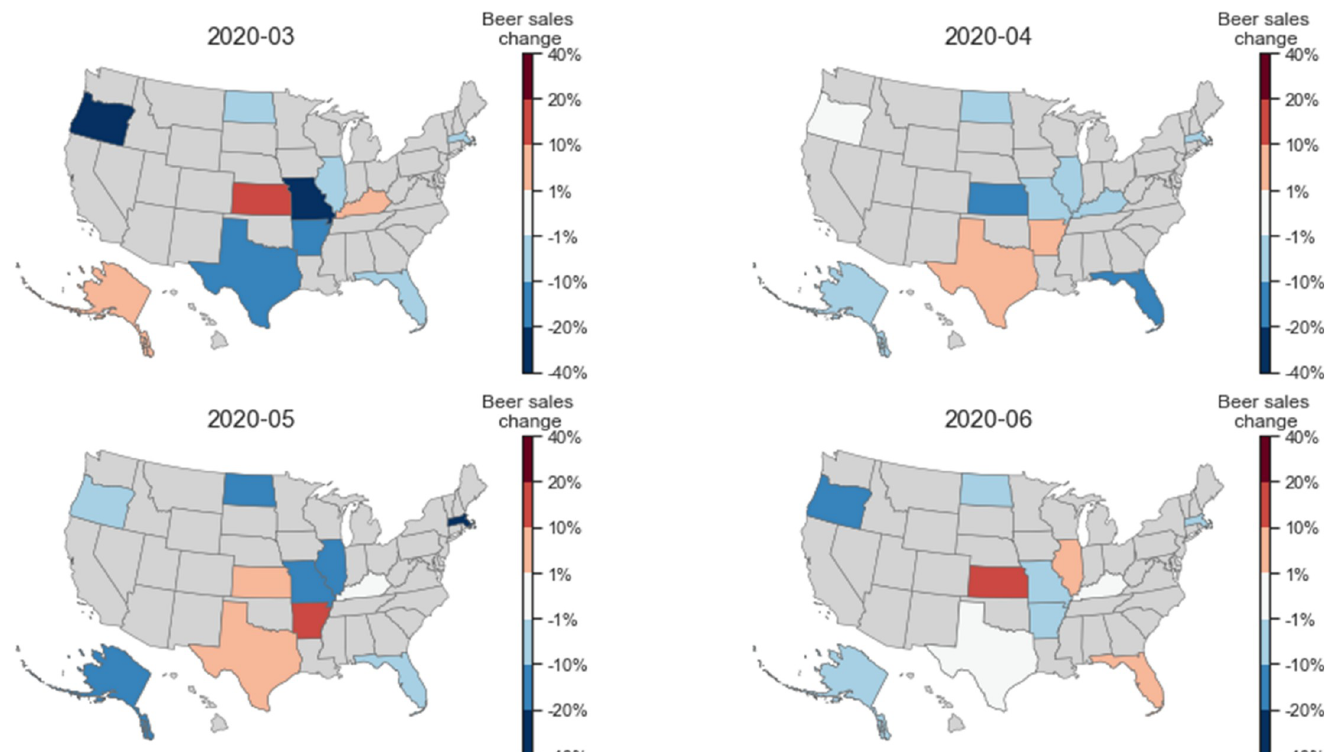
Fig 8. Geographic differences for how the per capita sales of beer changed during the pandemic. The percentage change for each state is compared to the average sales during the same months in 2018 and 2019.